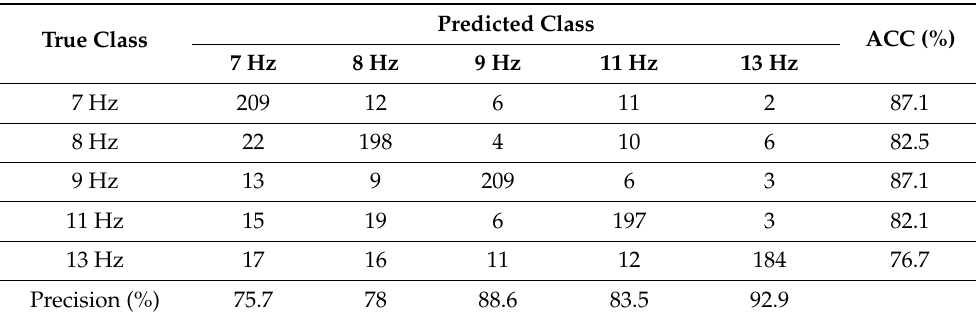
Table 3. The confusion matrix for the SSVEP recognition results using CCA classifier for the map test in the first experiment (Scenario 3).